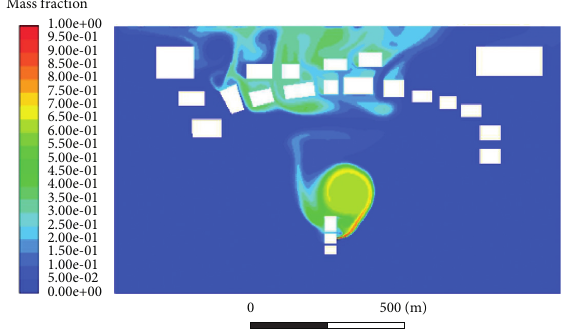
Figure 7: Radionuclide dispersion at the eastern